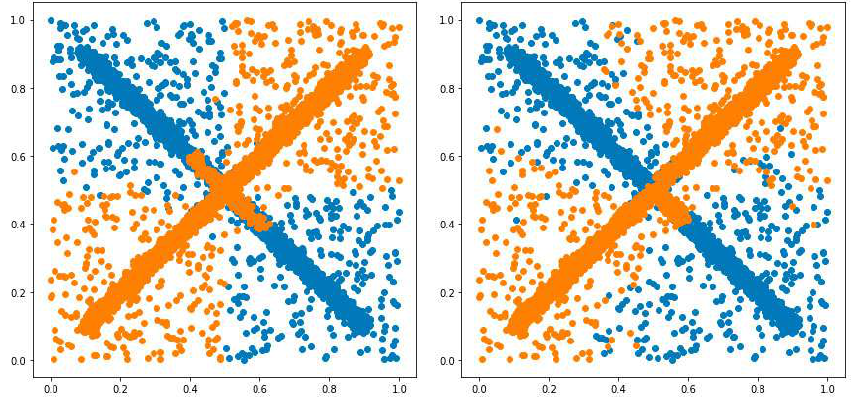
Figure 4. Example of instances from the DS 4 , classified by HPFuzzNDA (the left graph) and PFuzzND (the right graph)